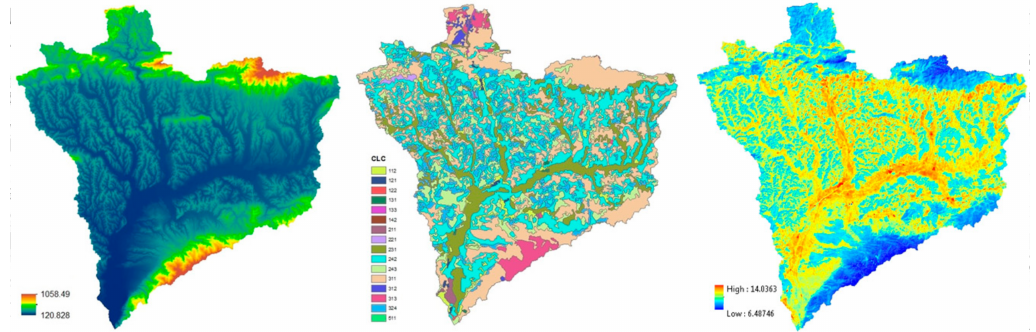
Figure 2. Krapina River Basin: elevation ( left ) H (m a.s.l.), Corine Land Cover map ( middle ) with class codes and mean annual air temperature ( right ) T ( ◦